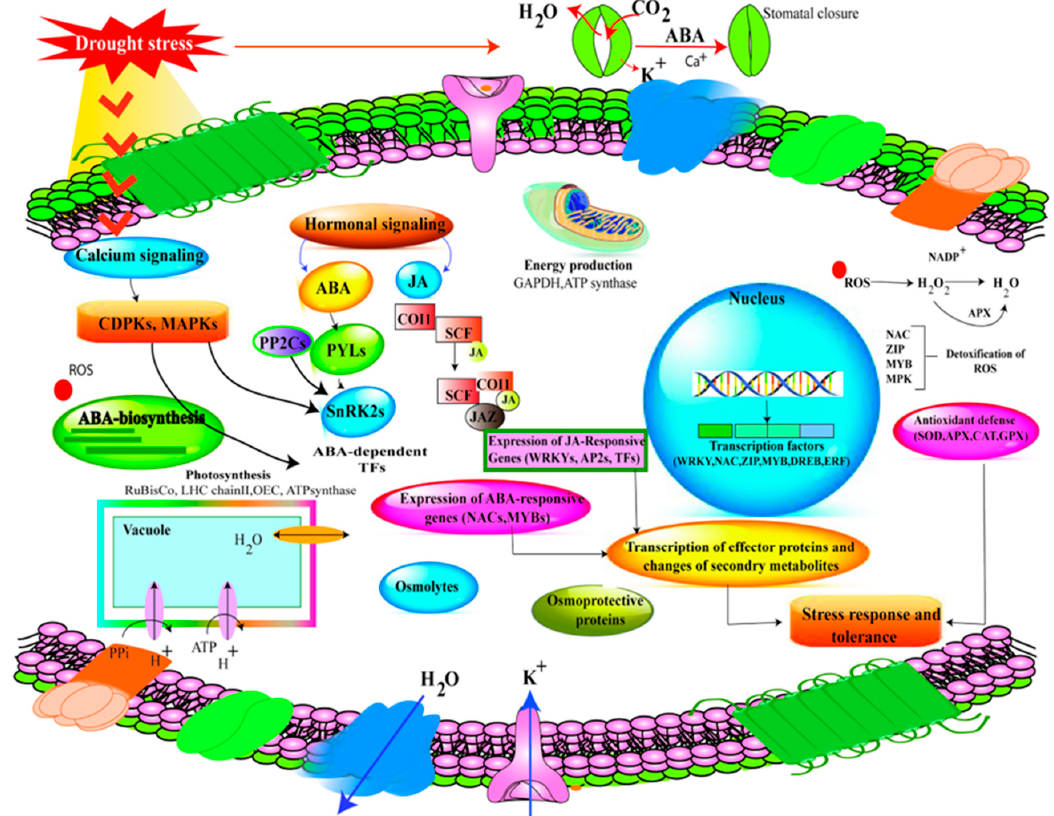
Figure 2. Schematic representation of drought tolerance mechanism in legumes. Reactive oxygen species (ROS), Ca 2 + , ABA, and JA are activated under DS. DS induces biosynthesis of ABA and JA, which, in turn, up-regulate the transcription of ion transporter genes. Overexpression of transcription factors ( WRKY , GmNACs , DREB, ZIP , AP2 / ERF , MYB) has been reported under DS. ABA, abscisic acid; JA, Jasmonic acid.